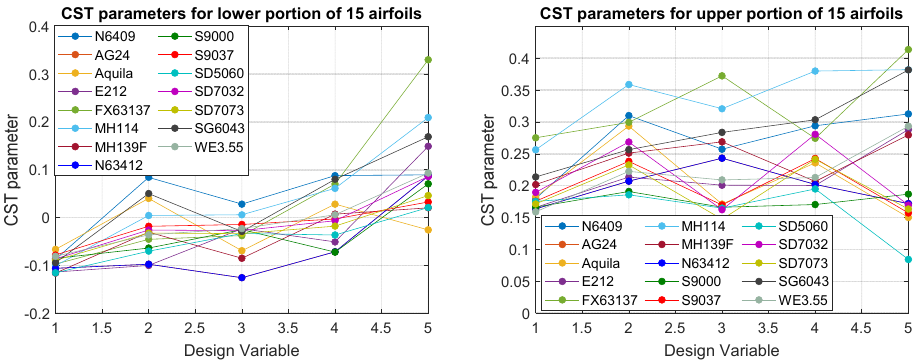
Figure 4. CST parameter for 15 airfoils recommended for solar UAVs.